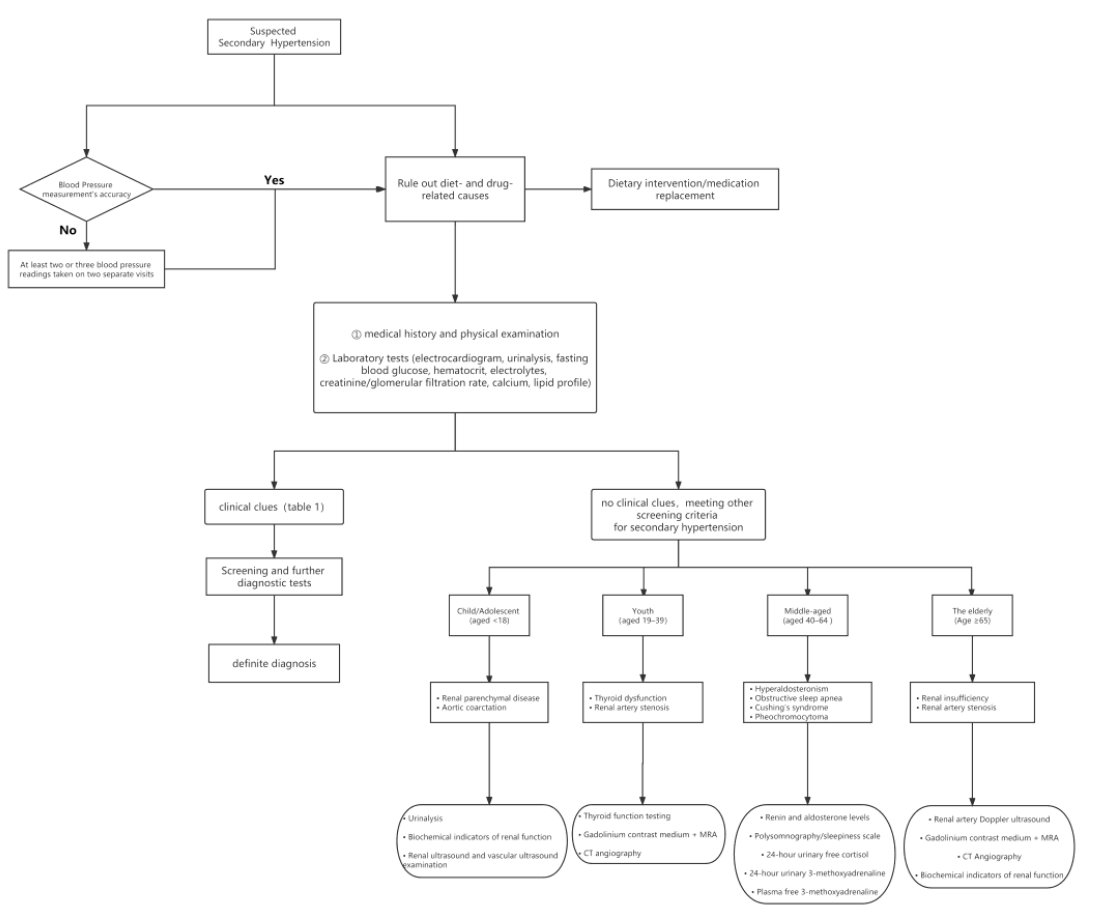
Figure 2. Recommended screening process for patients with suspected secondary hypertension. CT: computed tomography; MRA: magnetic resonance angiography.